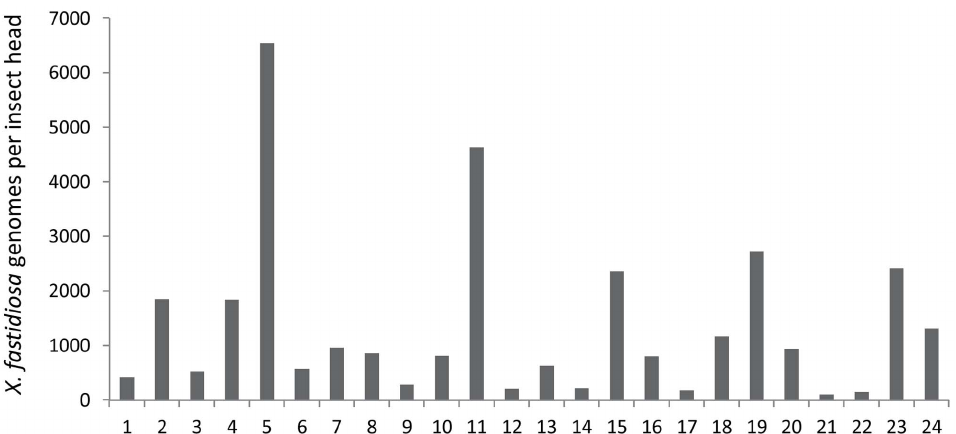
Figure 4. X.fastidiosa genomes per GWSS head. Quantitative RT-PCR was used to measure the number of X. fastidiosa genomes associated with 24 different dissected GWSS heads from the colony.